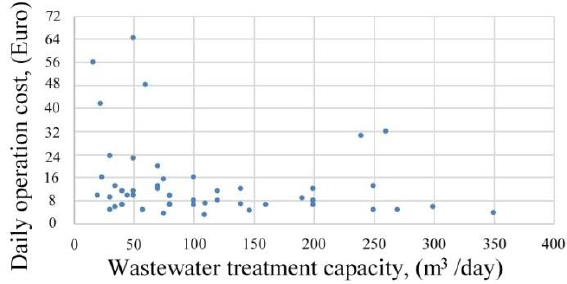
Figure 6. Daily operating costs and wastewater treatment capacities of facilities